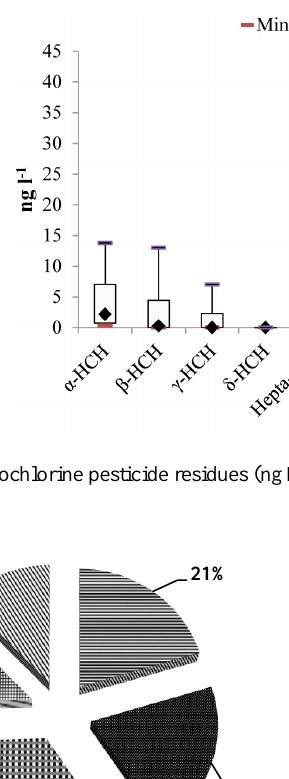
Figure 8. Detection frequency of individual OCPs across BR stretch of Ganga Figure 8: Detection frequency of individual OCPs across BR stretch of Ganga River